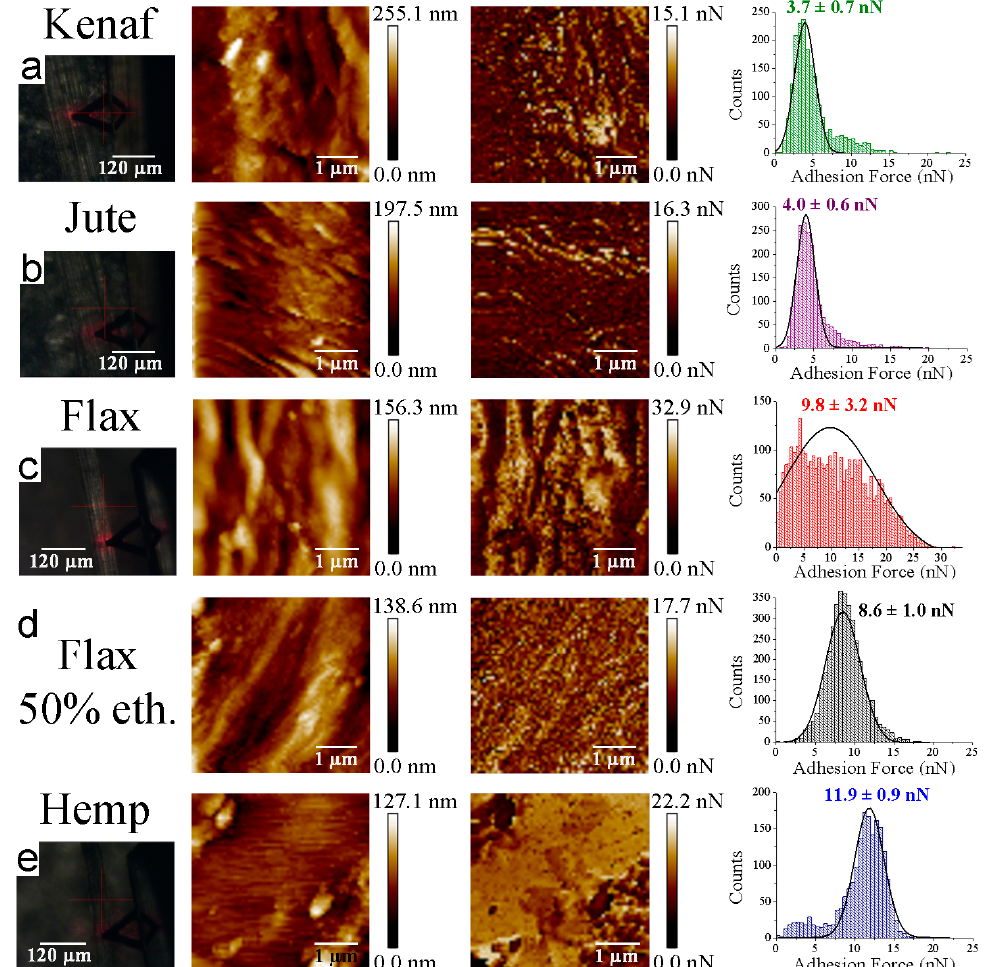
Figure 5. Force–volume experiments conducted between PBS functionalized tip and ( a ) kenaf, ( b ) jute, ( c ) flax, ( d ) flax washed with 50% ethanol, and ( e ) hemp fibers. From left to right side: zenithal optical microscope view, F–V topography map, F–V force adhesion map, and the histogram force distribution for each assessed plant fibers.